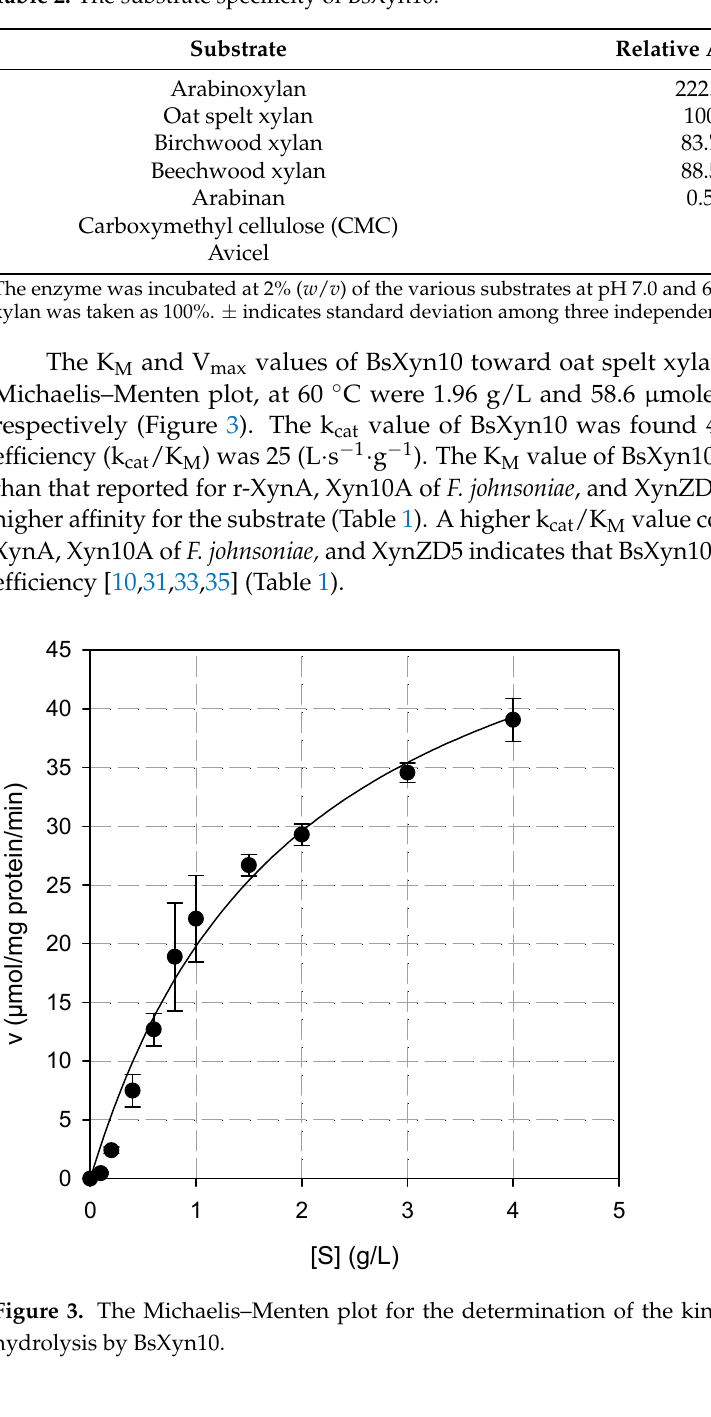
Table 2. The substrate specificity of BsXyn10.